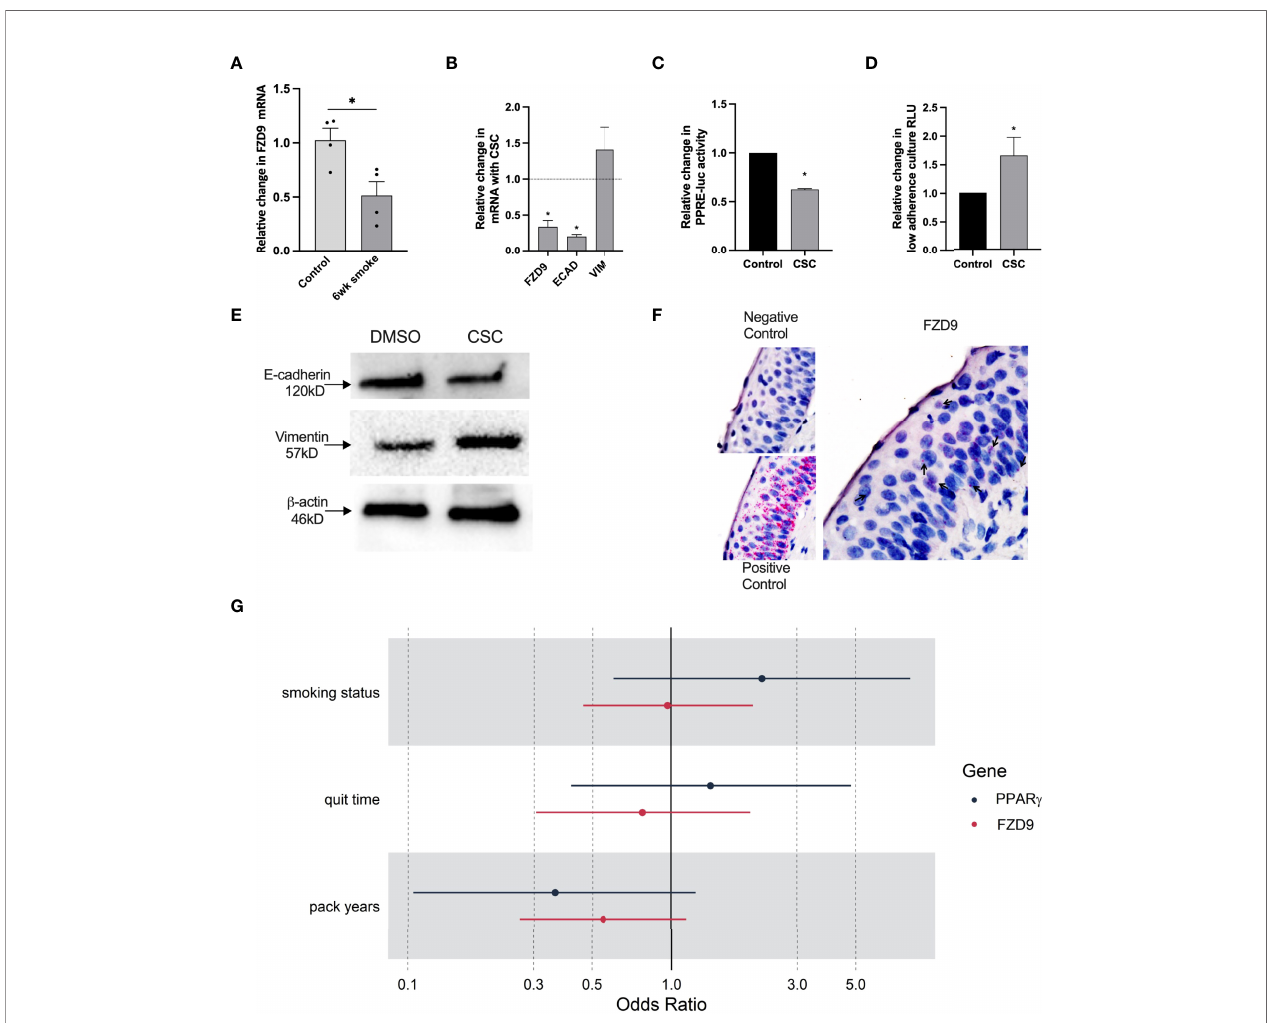
FIGURE 6 | FZD9 expression decreases with smoke exposure. (A) Change in FZD9 expression in mice after six weeks of exposure to cigarette smoke or ambient air control, measured by qPCR. Results are normalized to RPS18 and conducted in triplicate. (B – D) HBEC3KT were treated with 5ug/ml CSC or DMSO every 48 hours for two weeks and analyzed for (B) FZD9, Ecad, and VIM expression by qPCR, (C) PPRE-luc activity by transfection, (D) viability in a low-adherence culture, and (E) Ecad and VIM protein expression by western blot, with b -actin loading control. Signi fi cance in A-E was measured by a two-tailed t-test and *p<0.05. CSC, cigarette smoke condensate. Treatments, transfections, luciferase assays, and qPCR was conducted in triplicate. qPCR results are normalized to GAPDH. Data is shown relative to control. (F) Representative images for RISH signal in negative control, positive control, and FZD9. (G) Odds ratios for the effect of smoking characteristics on FZD9 and PPAR g expression at baseline, where someone with higher pack year exposure to smoke has lower odds of high FZD9